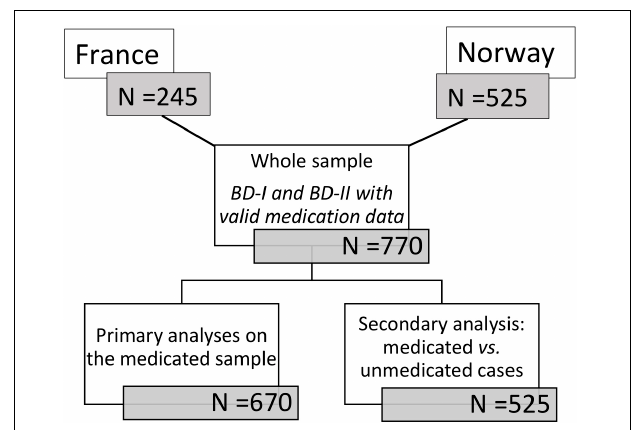
FIGURE 1 | Flowchart for sample